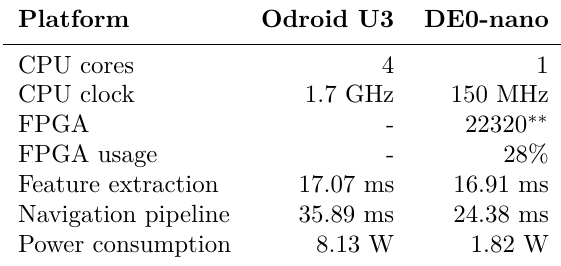
Table 1. Navigation pipeline processing results of Odroid U3 and DE0-nano SoC